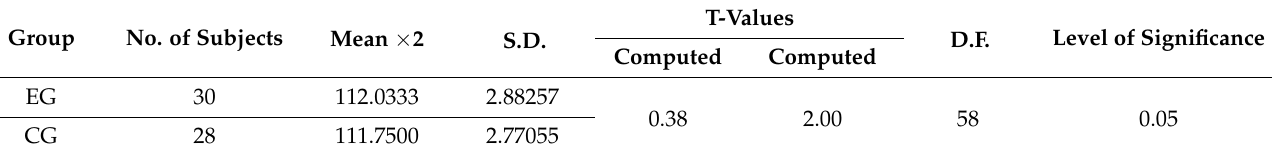
Table 4. The Mean Score, Standard Deviation, And T-Values Of Pupils’ Age In Months.